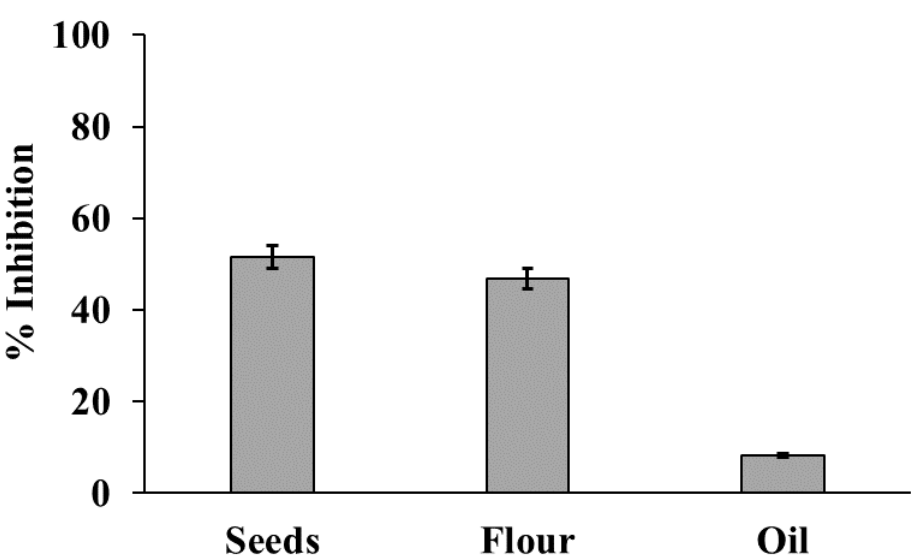
Figure 2. Antioxidant capacity (DPPH test) of seeds, flour, and oil hemp extracts (0.2 g mL − 1 ). The results are expressed as inhibition %. Trolox ® was used as a positive control for DPPH inhibition (see text). Data are means ± SD of three independent determinations.